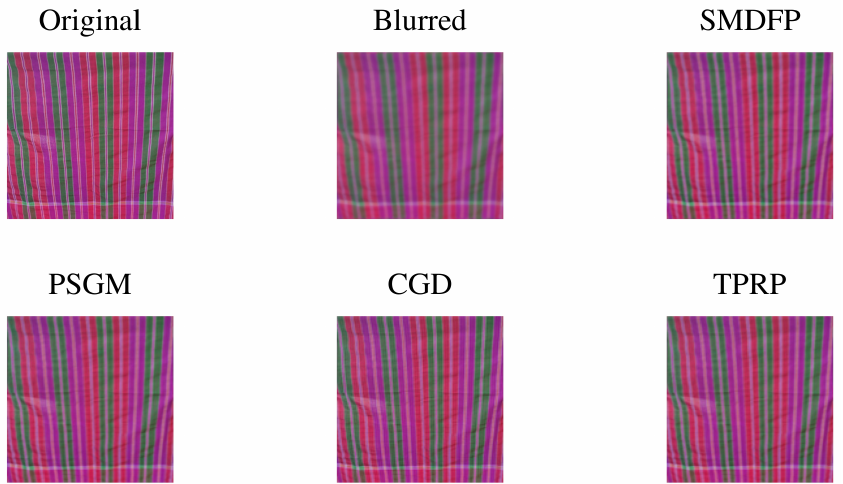
Figure 10. Comparison of the original image, blurred image, SMDFP image, CGD image, PSGM image, and TPRP image for the number of iterations, CPU time, MSE, and